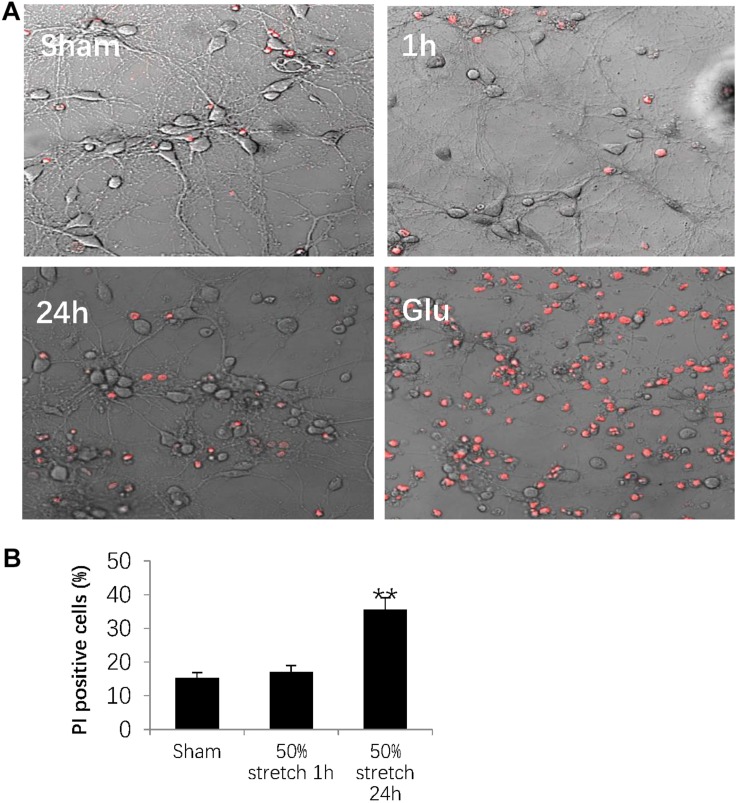
Stretch-induced neuronal cell death. (A) Representative images showing 50% stretch-induced neuronal cell death 1 and 24 h post-injury. Dead cells were detected by propidium iodide (PI) staining (red fluorescence), and total cell number was measured using transmitted light under confocal microscopy. The positive control was defined as a 24-h neuronal culture treated with 0.5 mM glutamate (Glu) for 30 min. (B) Quantitative analysis of neuronal cell death by calculating the ratio between the numbers of PI-positive cells and total cells (all data were presented as mean ± SE; one-way ANOVA, n = 15 in each group from three independent chambers; ∗∗P < 0.01). Scale bar = 100 μm.